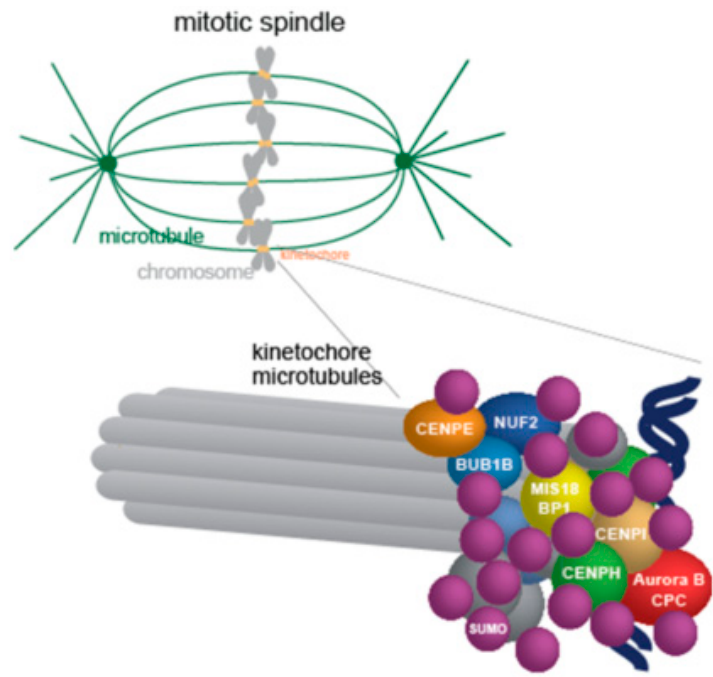
Figure 3. The kinetochore may contain group SUMOylated subcomplexes. A large number of kinetochore proteins have been identified as SUMO conjugates (see Table 2). Specific subcomplexes